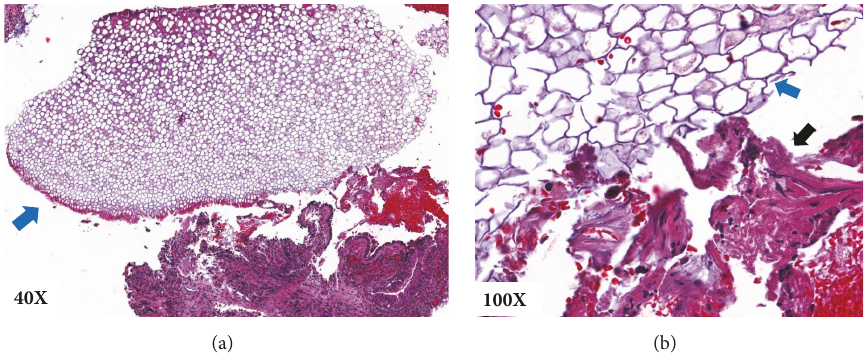
Figure 3: Hematoxylin and eosin stained images of the foreign body show vegetable matter with thick cell walls associated with plants (blue arrow) and acute inflammation with tissue debris (black arrow) under 40x (a) and 100x (b)